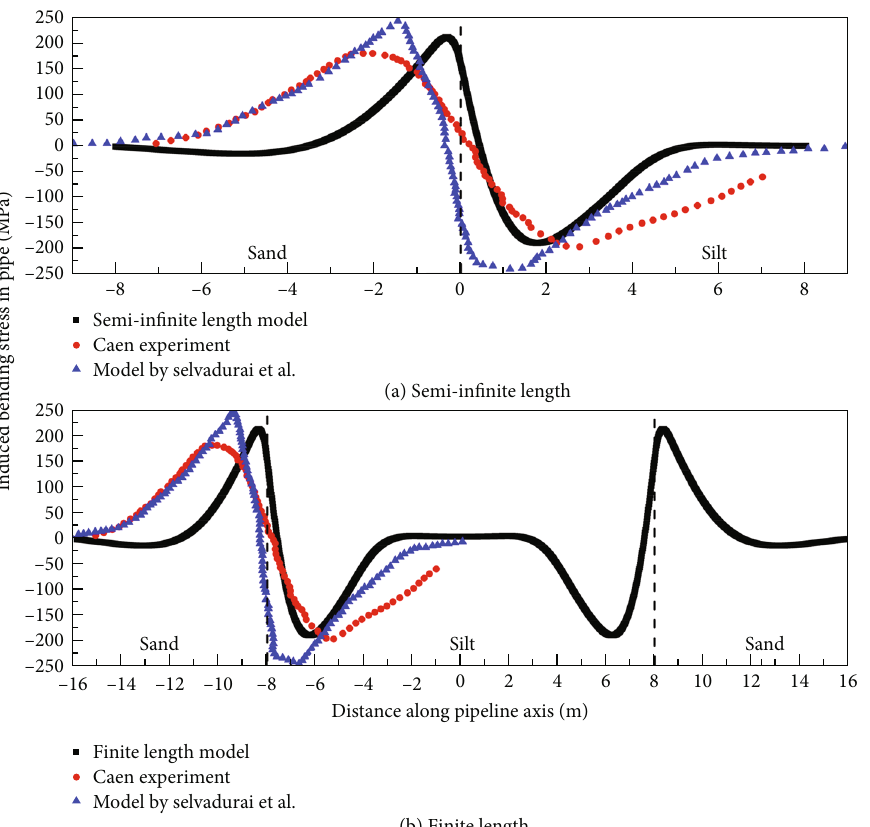
Figure 4: Comparison results of bending stresses in the pipeline subjected to di ff erential frost heave between Caen experiment in France, computational estimates by Selvadurai et al., and di ff erential frost heave models in this paper: (a) semi-in fi nite length model and (b) fi nite length model.